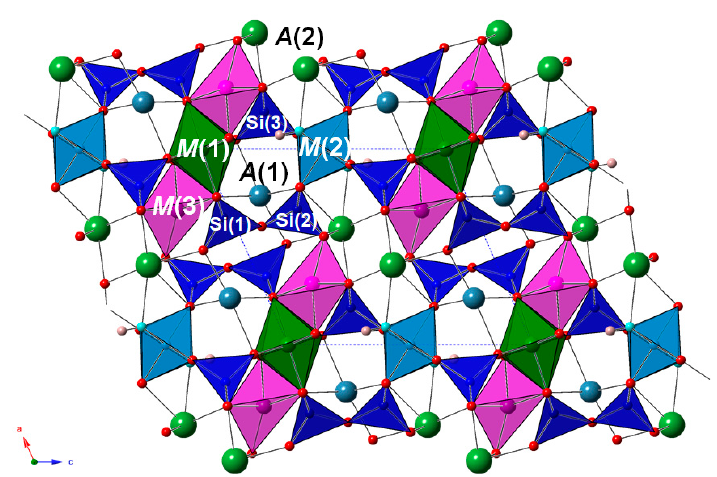
Figure 4. Crystal structure of epidote supergroup minerals as seen down [010].